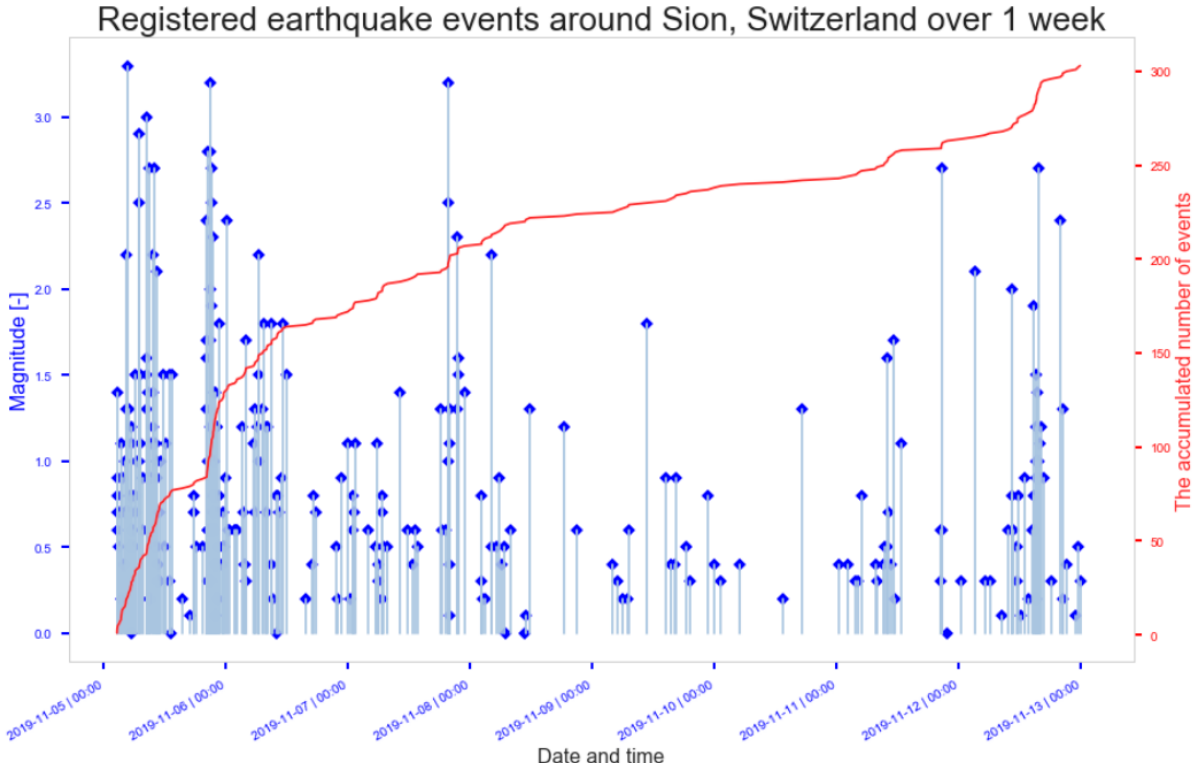
Figure 5. Earthquake activity around Sion (VD), Switzerland during the analyzed week of 5–13 November 2019.